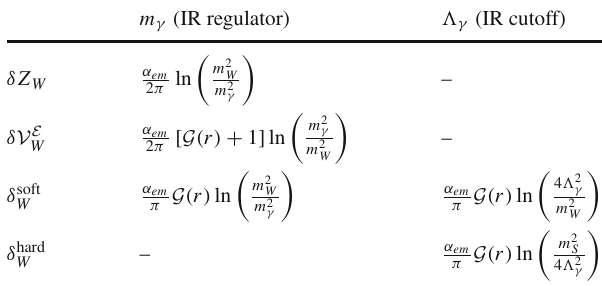
Table 2 IR-dependence on m γ and (cid:19) γ in δ Z W , δ V E